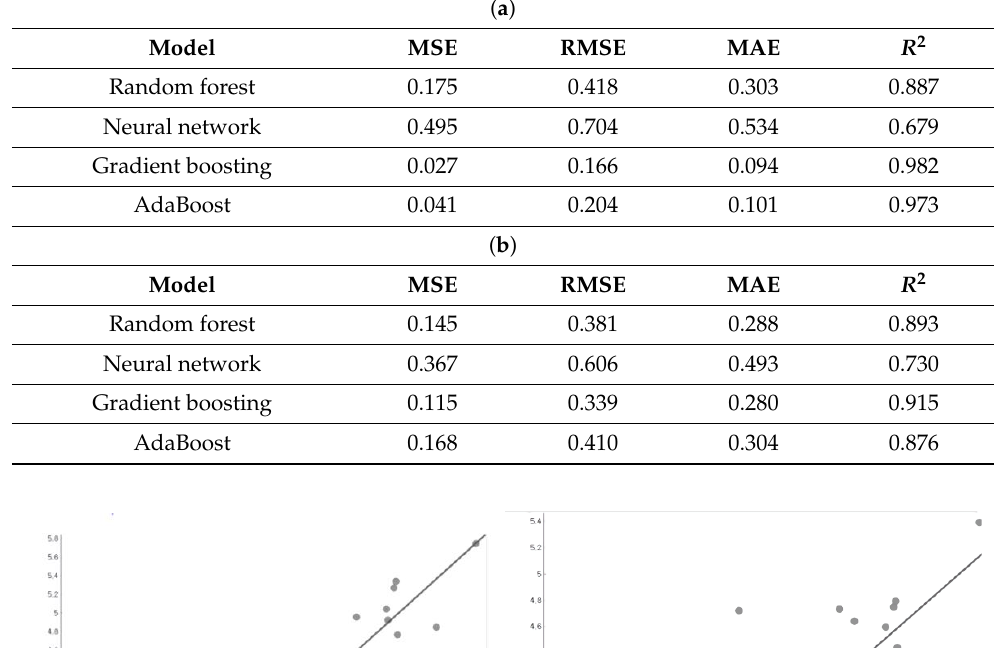
Table 10. ( a ). Result of ML models with training average data excluding outliers. ( b ). Result of ML models with testing average data excluding outliers.